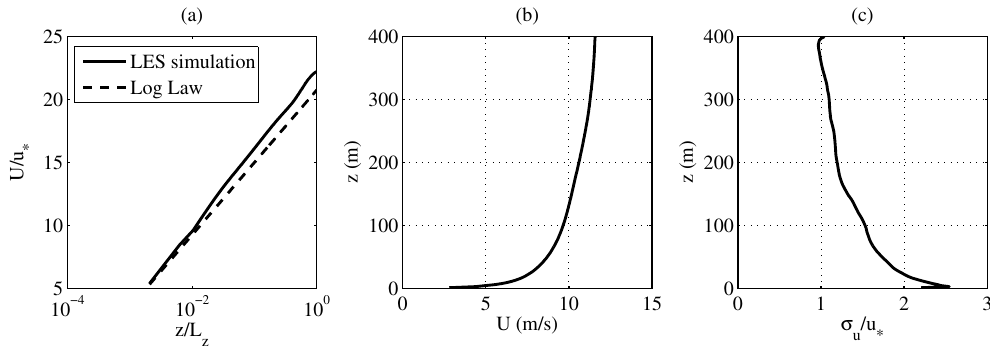
Figure 3. Inflow characteristics: ( a ) vertical profile of the mean streamwise velocity compared to a log-law profile (horizontal axis in logarithmic scale); ( b ) vertical profile of the mean streamwise velocity (linear scale); ( c ) vertical profile of the standard deviation of the streamwise